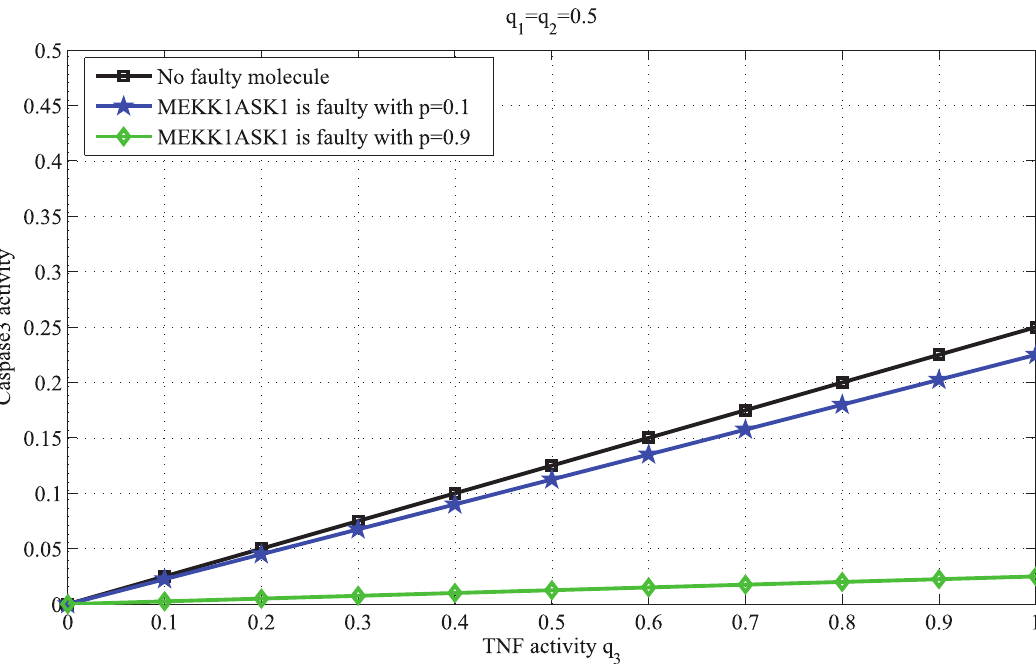
Figure 5. Caspase3 activity in terms of the TNF activity q 3 , when MEKK1ASK1 is faulty. In this figure the activity of TNF changes from 0 to 1, whereas the activities of EGF and insulin are the same, q 1 ~ q 2 ~ 0 : 5 . As a baseline, the black graph shows the output activity when there is no faulty molecule. When MEKK1ASK1’s fault probability is small, p ~ 0 : 1 , the output activity slightly decreases (blue graph). However, when MEKK1ASK1’s fault probability is large, p ~ 0 : 9 , the output activity decreases significantly (green graph).